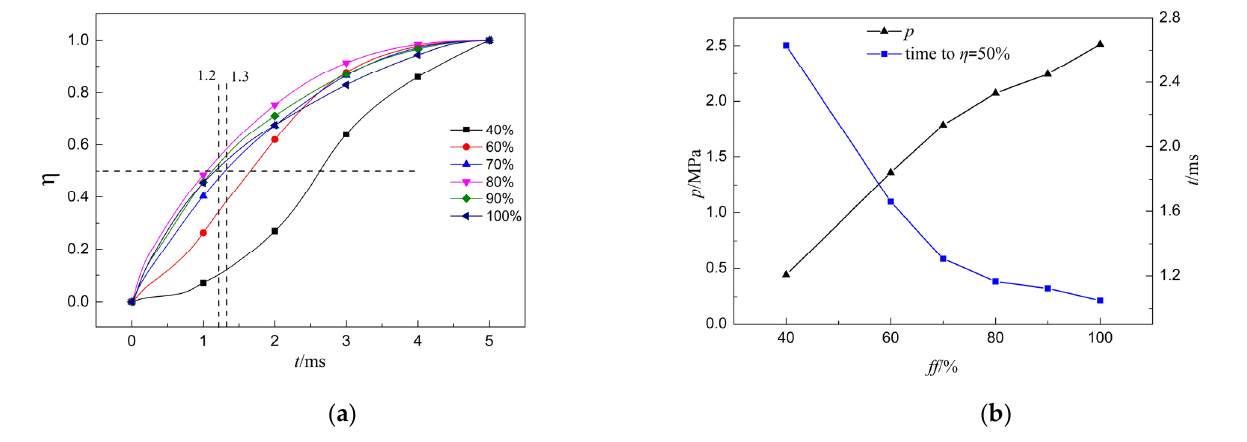
Figure 9. ( a ) The ratio η at different times in the 350–1100 nm band of different fill fractions, ( b ) Variation of pressure and the time to satisfy Et = 50%E0 (i.e., η = 50%) of different fill fractions.